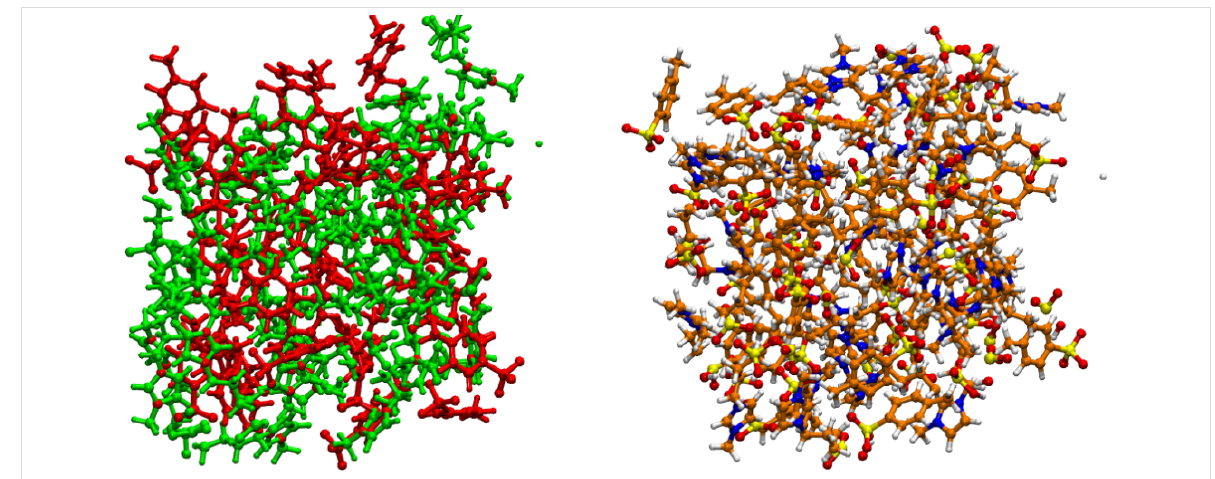
Figure 1: Ball-and-stick representation of the simulation box. Visualized with TRAVIS [43] and vmd [44]. Left: cations in green and anions in red. Right: carbon in orange, sulfur in yellow, oxygen in red, nitrogen in blue, and hydrogen in white.